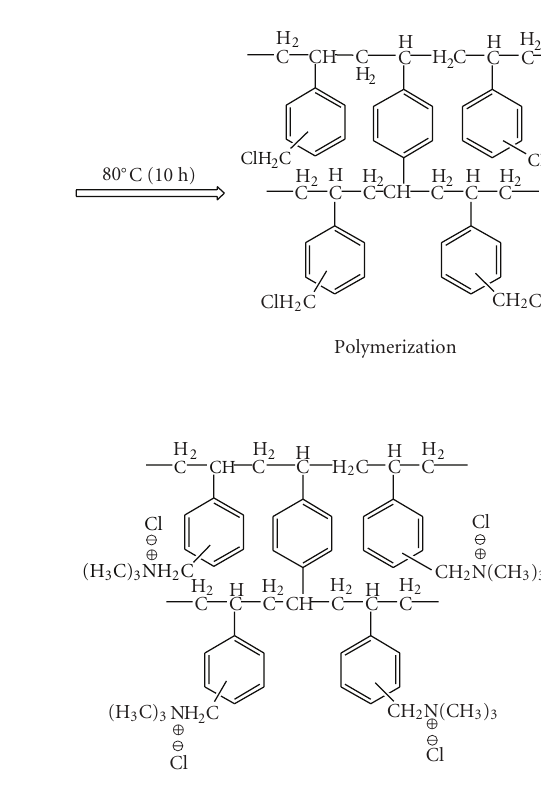
Figure 1: Polymerization and functionalization of anion exchange polymer.